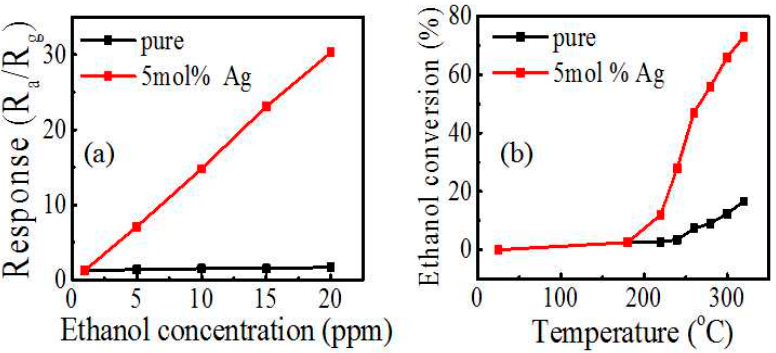
Figure 7. ( a ) Response change of the pure and 5 mol % Ag-modified In 2 O 3 sensors to different ethanol concentrations at 300 °C; ( b ) ethanol conversion of the pure and 5 mol % Ag-modified In 2 O 3 sensors as a function of reaction temperature over catalysts.